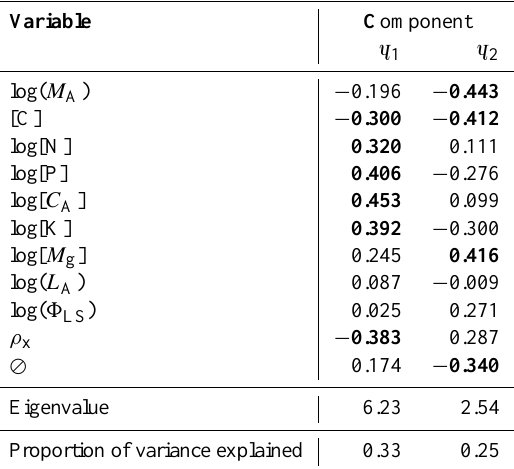
Table 4. Summary of the Principal Components Analysis of the correlation matrix for the derived environmental/soil effects on ob- served structural and physiological traits. Coefficients given in bold are those whose values are 0.3 or more. M A = leaf mass per unit area; elemental concentrations are on a dry weight basis, L A = leaf area; 8 LS = leaf area: sapwood area ratio, ρ x = branch xylem den- sity, (cid:11) = diffusion limitation index (see Eq.